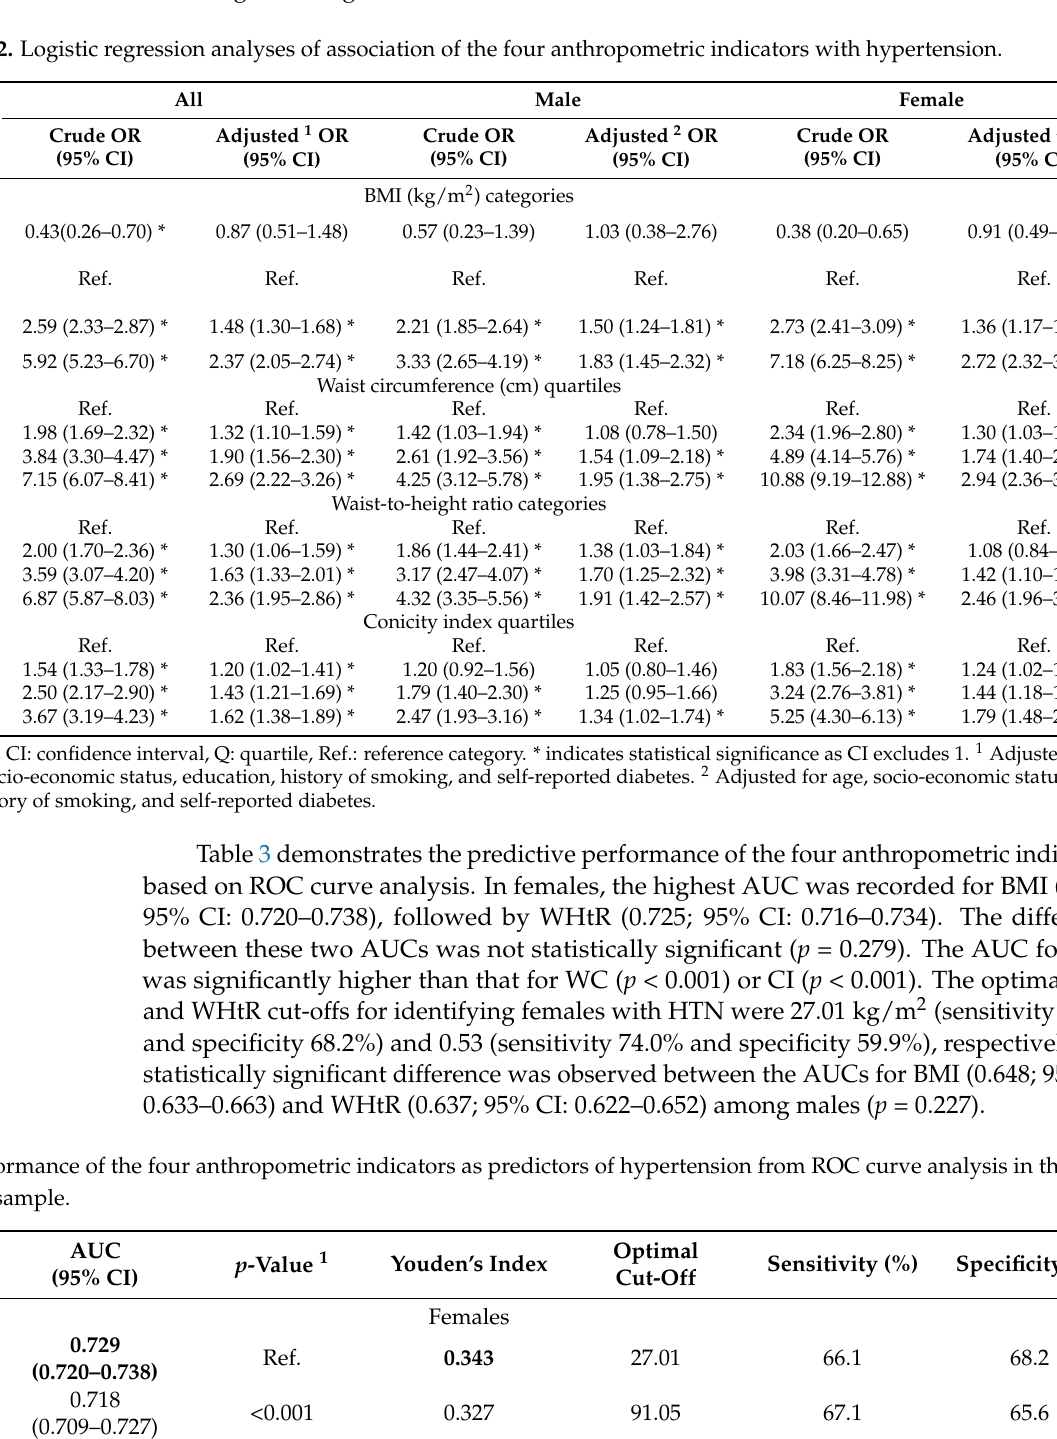
Table 2. Logistic regression analyses of association of the four anthropometric indicators with hypertension. All Variables